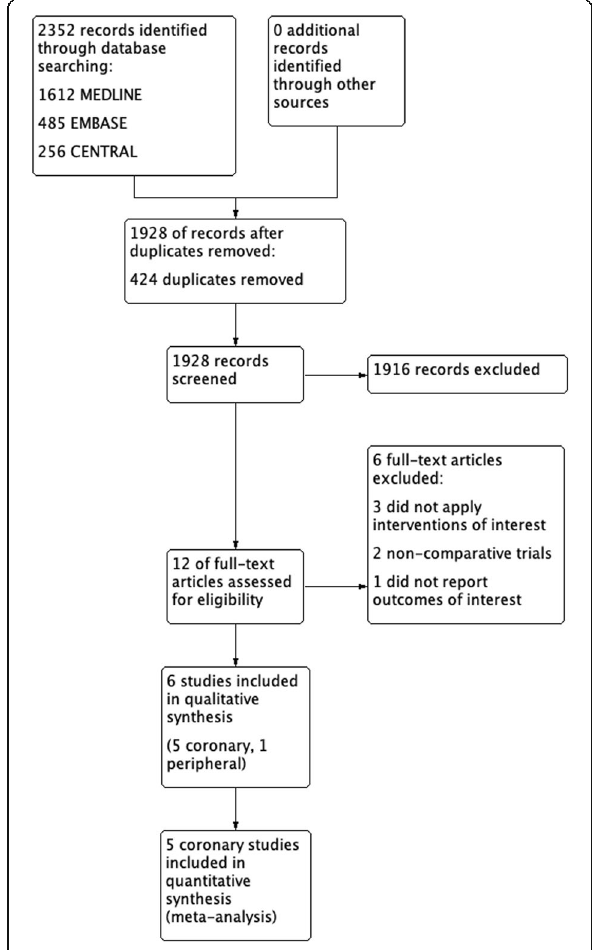
Fig. 1 Systematic review PRISMA study flow diagram. In total, the 6 studies included in the qualitative and quantitative analysis included 1496